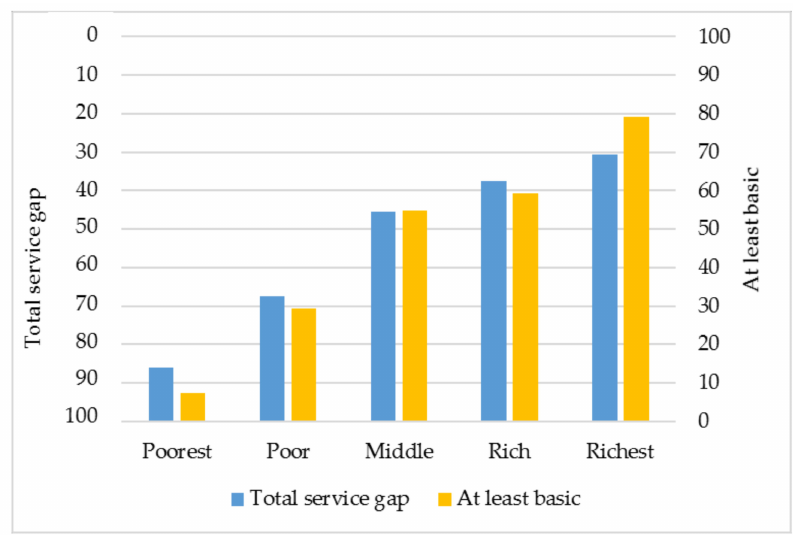
Figure 6. Comparison of the ‘total service gap’ with ‘at least basic services’ across wealth quintiles in Senegal,